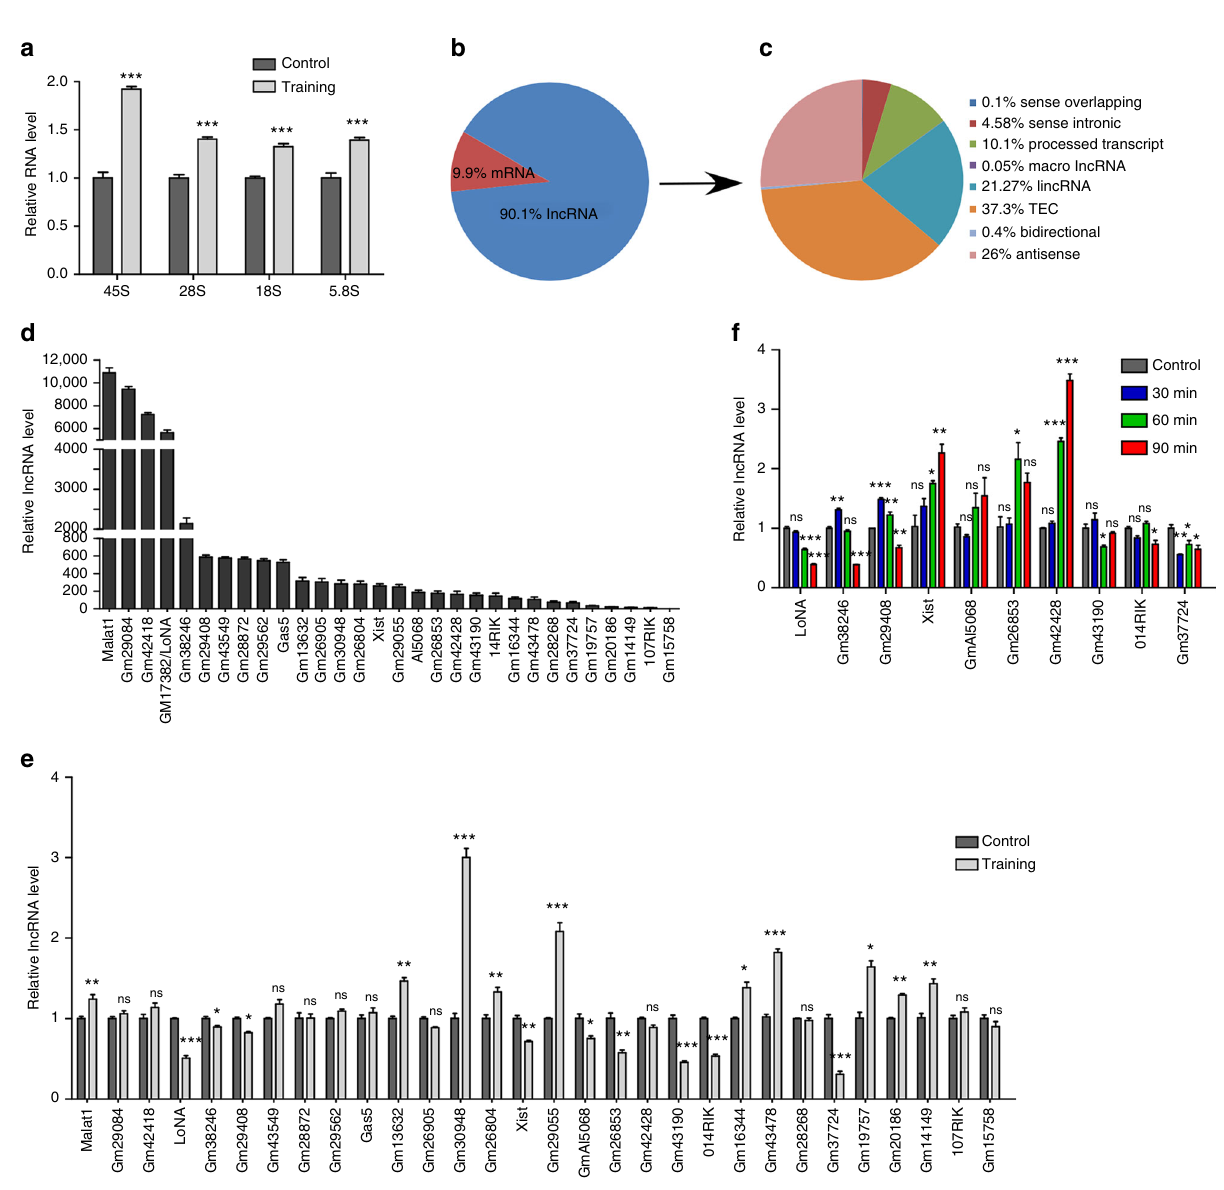
Fig. 1 Identi fi cation of nucleolar lncRNAs from trained mouse brain and activated neurons. a rRNA levels (45S, 28S, 18S, and 5.8S) in hippocampal brain from spatial learning-induced mice in Morris water maze and control mice (24 h after training, n = 5 for each group), as measured by qPCR. Data were normalized against U1 snRNA. b , c Total RNA was extracted from N2a cell nucleoli, and fragments longer than 200 nt were subjected to RNA-seq. b Relative abundances of mRNA and lncRNA in nucleoli. c Distribution of detected nucleolar lncRNA RNA-seq peaks. d qPCR validation of expression for the 30 most abundant lncRNA in the nucleoli of N2a cells ( n = 3), expression is presented as fold difference over Gm15758 (the least abundant one among the top thirty). e Expression of the 30 most abundant lncRNAs (validated in d ) in hippocampal brain of experience induced and control mice ( n = 5), as determined by qPCR. f Expression of the ten most signi fi cantly downregulated lncRNAs (determined in e ) in KCL-activated primary neurons at various time point ( n = 3 at each time point), determined by qPCR. In a , d , e , f , error bars, s.e.m.; * P < 0.05; ** P < 0.01; *** P < 0.001 by ANOVA or two-tailed Student ’ s